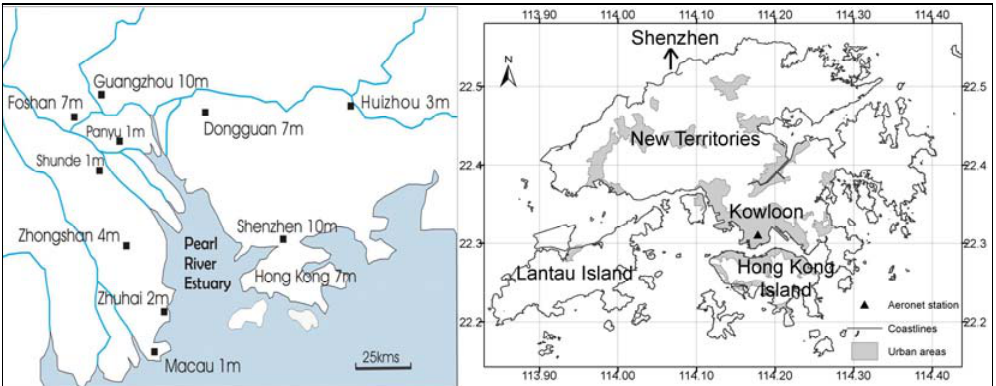
Figure 1. Urban areas of Hong Kong, and location adjacent to the large industrial cities of the Pearl River Delta with populations given in